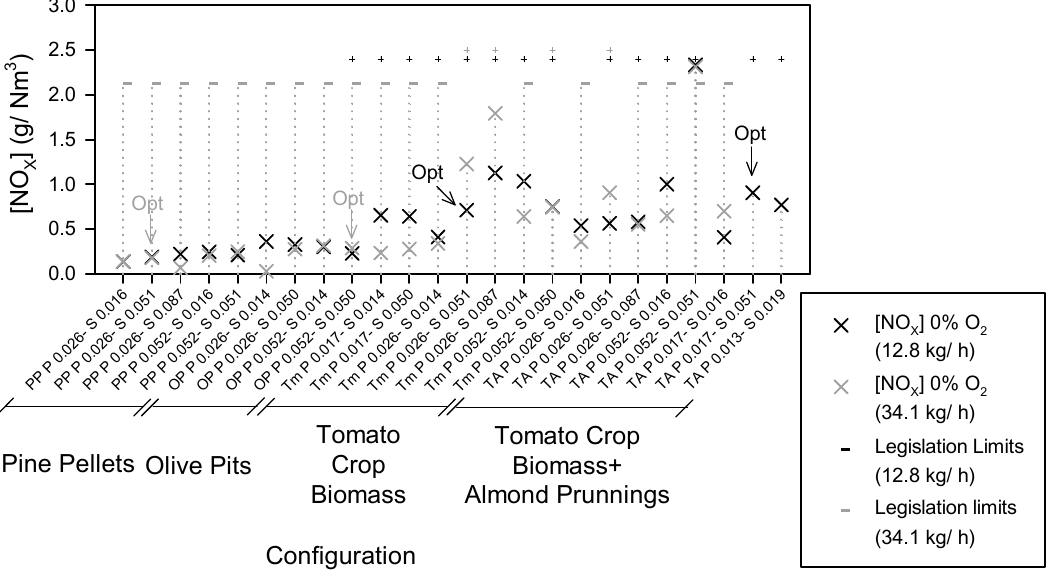
Figure 8. [NO X ] 0% O 2 observed for each biomass type, their corresponding fuel rates, and the primary and secondary air supply rates (*Legislation limit outside the graph scale. Opt: Configuration identified as optimum).